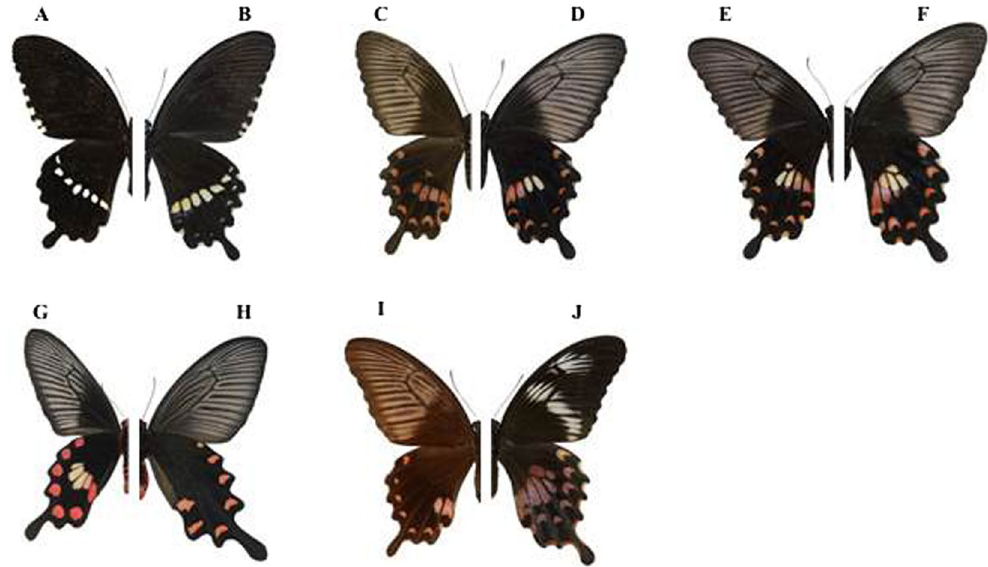
Figure 1. ( A ) A Papilio polytes male and ( B ) a P . polytes f. cyrus non-mimetic female, with basically the same wing colour pattern. ( C – F ) P . polytes f. polytes resembles ( G ) Pachliopta aristolochiae . As shown, however, there is a large variation in wing patterns among f. polytes females. Some females, for example ( C ), lack a white spot in the hind wing, resembling ( H ) Byasa alcinous , another unpalatable butterfly. ( I ) P . polytes f. theseus and ( J ) f. romulus (from the University Museum, University of Tokyo), which are not distributed in Japan, are considered to mimic ‘red plain